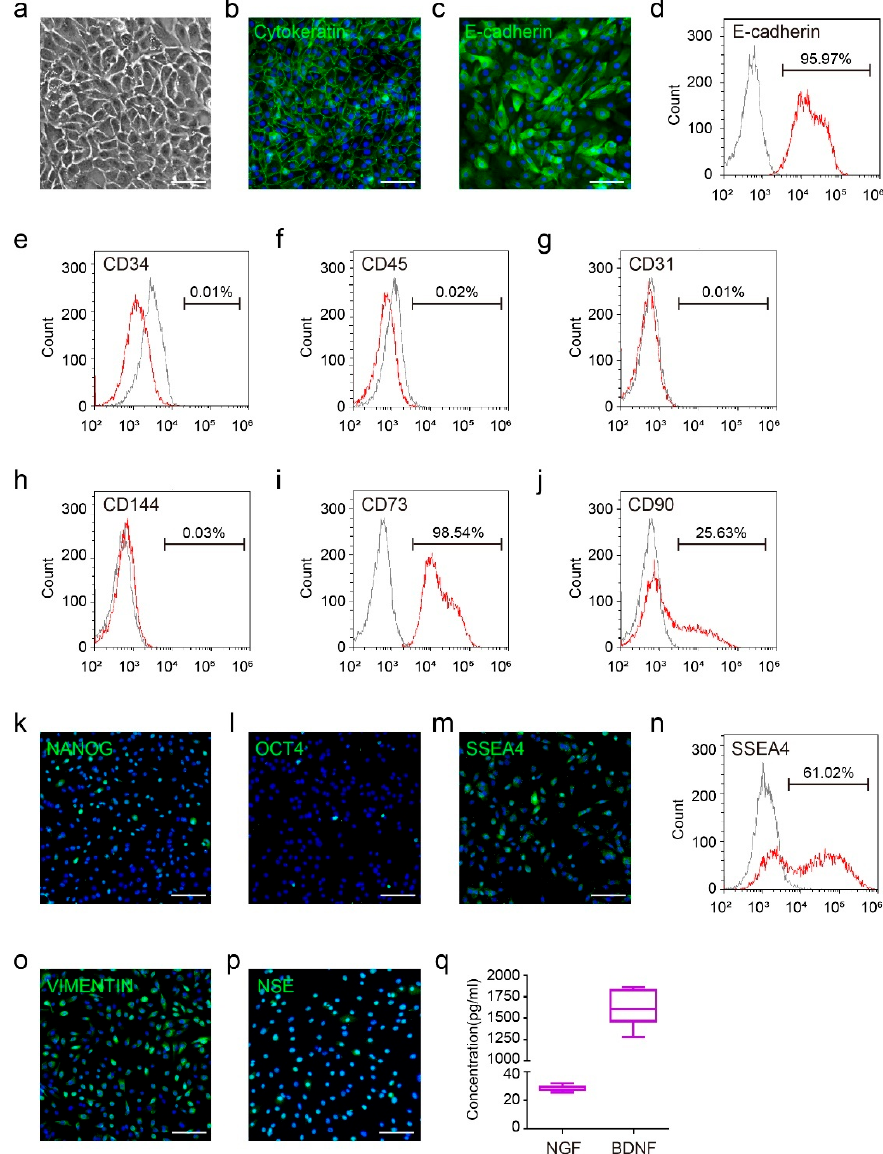
Figure 1. The basic characteristics of primary hAECs. ( a ) The morphology of primary hAECs; ( b , c ) the immunofluorescence staining of epithelial marker Cytokeratin and E-cadherin of primary hAECs; ( d ) the flow cytometry results of epithelial marker E-cadherin of primary hAECs; ( e – j ) the flow cytometry results of hematopoietic markers CD34 and CD45, endothelial markers CD31 and CD144 and mesenchymal markers CD73 and CD90 of primary hAECs; ( k – m ) the immunofluores- cence staining of pluripotent markers NANOG, OCT4 and SSEA4 of primary hAECs; ( n ) the flow cytometry results of pluripotent marker SSEA4 of primary hAECs; ( o , p ) the immunofluorescence staining of neural markers VIMENTIN and NSE of primary hAECs; ( q ) the ELISA results of neu- rotrophic factors NGF and BDNF of primary hAEC culture supernatant, n = 3. Scale bars: ( a – c ): 50 μ m; ( k – m ): 50 μ m; ( o , p ): 50 μ m. 3.2. The Establishment of BGVB Inducing-Treatment Approach To obtain hAEC-derived neural cells for cell replenishment in SCI lesions, we tried to establish an inducing-treatment approach by screening several small molecules and neurotrophic factors. Five different approaches were designed to culture hAECs in vitro